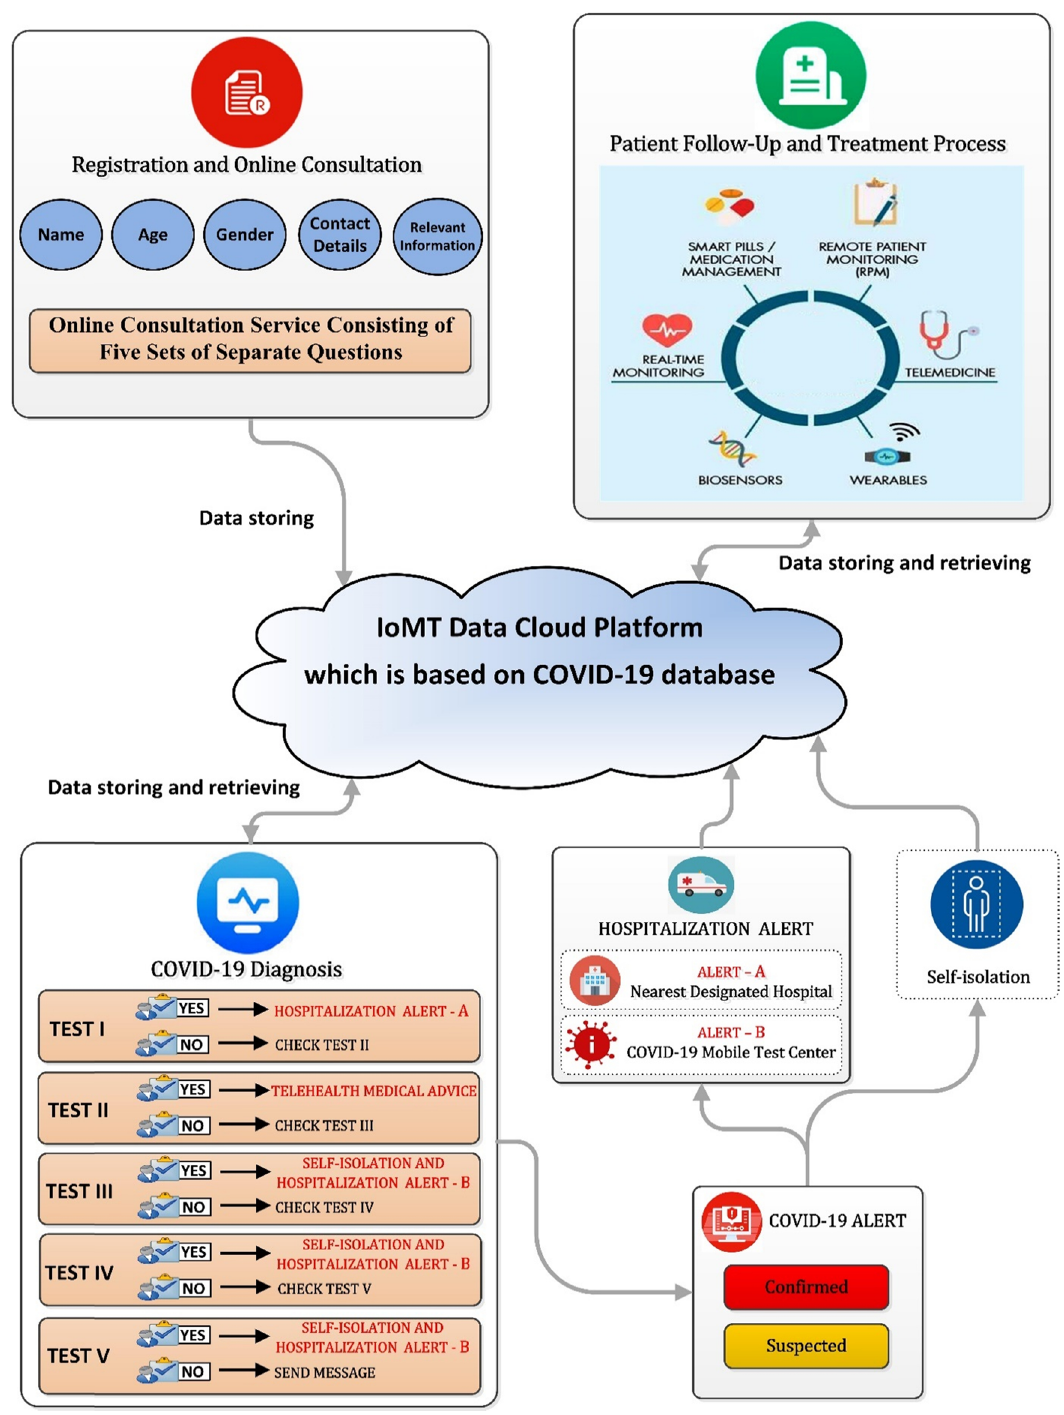
Figure 1: The proposed